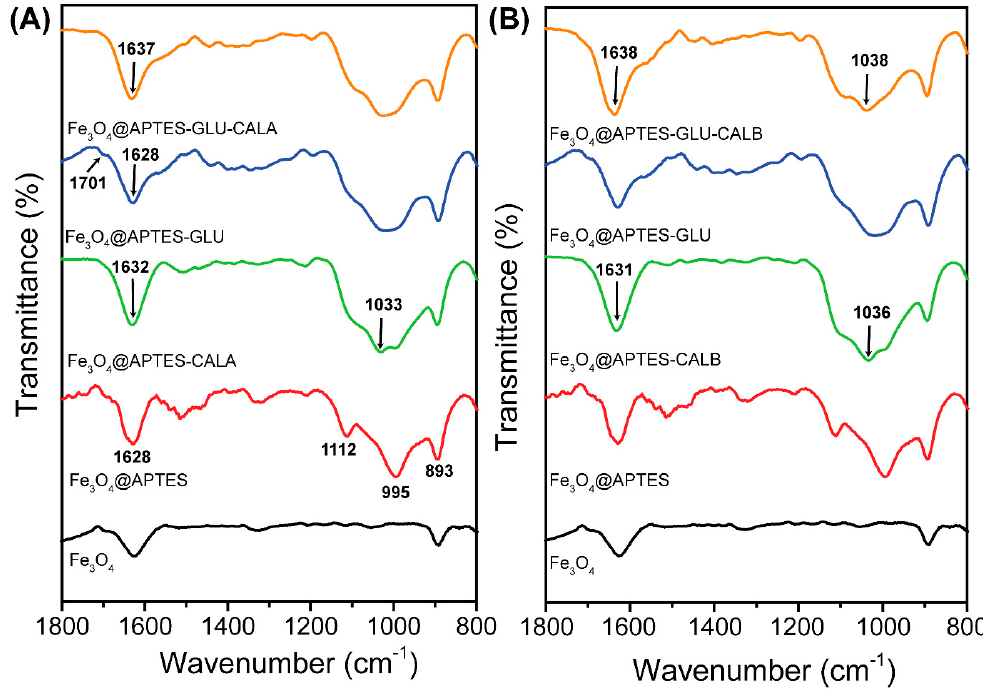
Figure 2. FT-IR spectra for the nanoparticles obtained in this communication. In each column is shown the series of spectra for ( A ) CALA and ( B ) CALB immobilization.